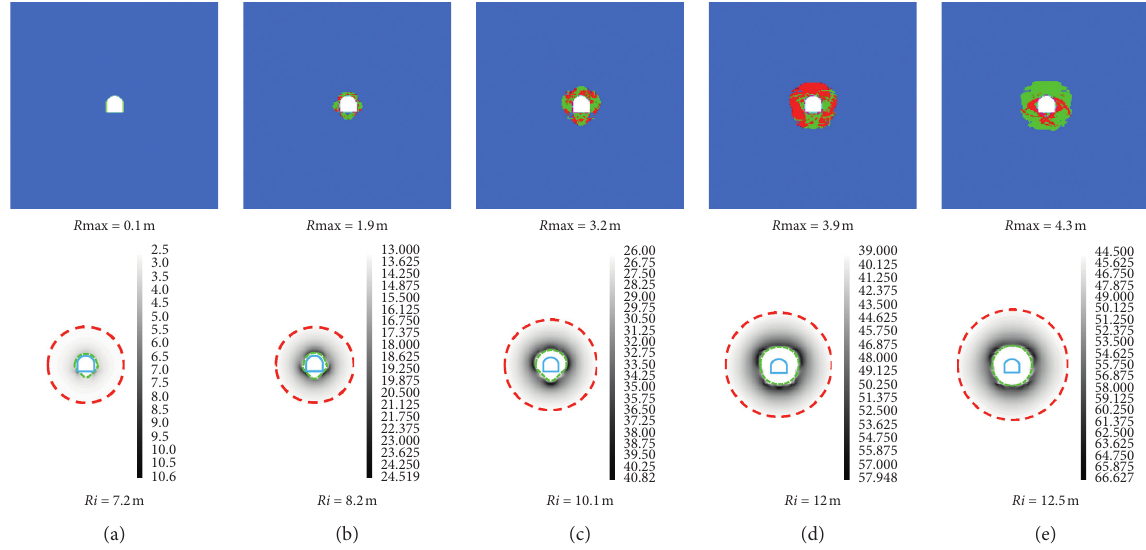
Figure 6: Plastic area and stress influencing area of surrounding rock of straight wall semicircular arched section: (a) H � 100m; (b) H � 500m; (c) H � 1000m; (d) H � 1500m; (e) H � 1700m.